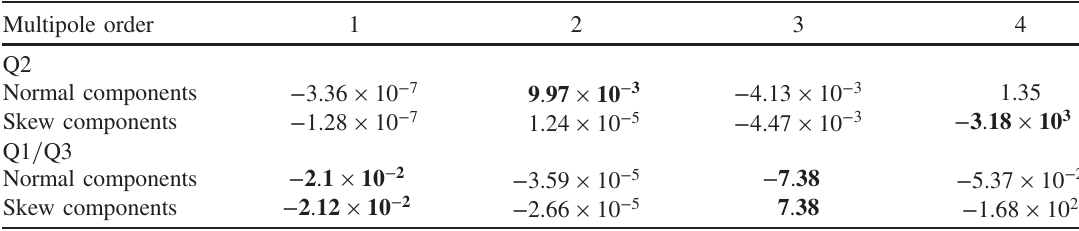
TABLE III. Summary of the multipolar decomposition 3 ms into the CLIQ discharge for all magnets without considering the shielding effect of the beam screen. The unit is in T = m ð n − 1 Þ , where n designates the pole order. Q1 and Q3 are identical. The components giving the largest kick on the beam, for beam orbits up to 20 mm, are in bold. Multipole order